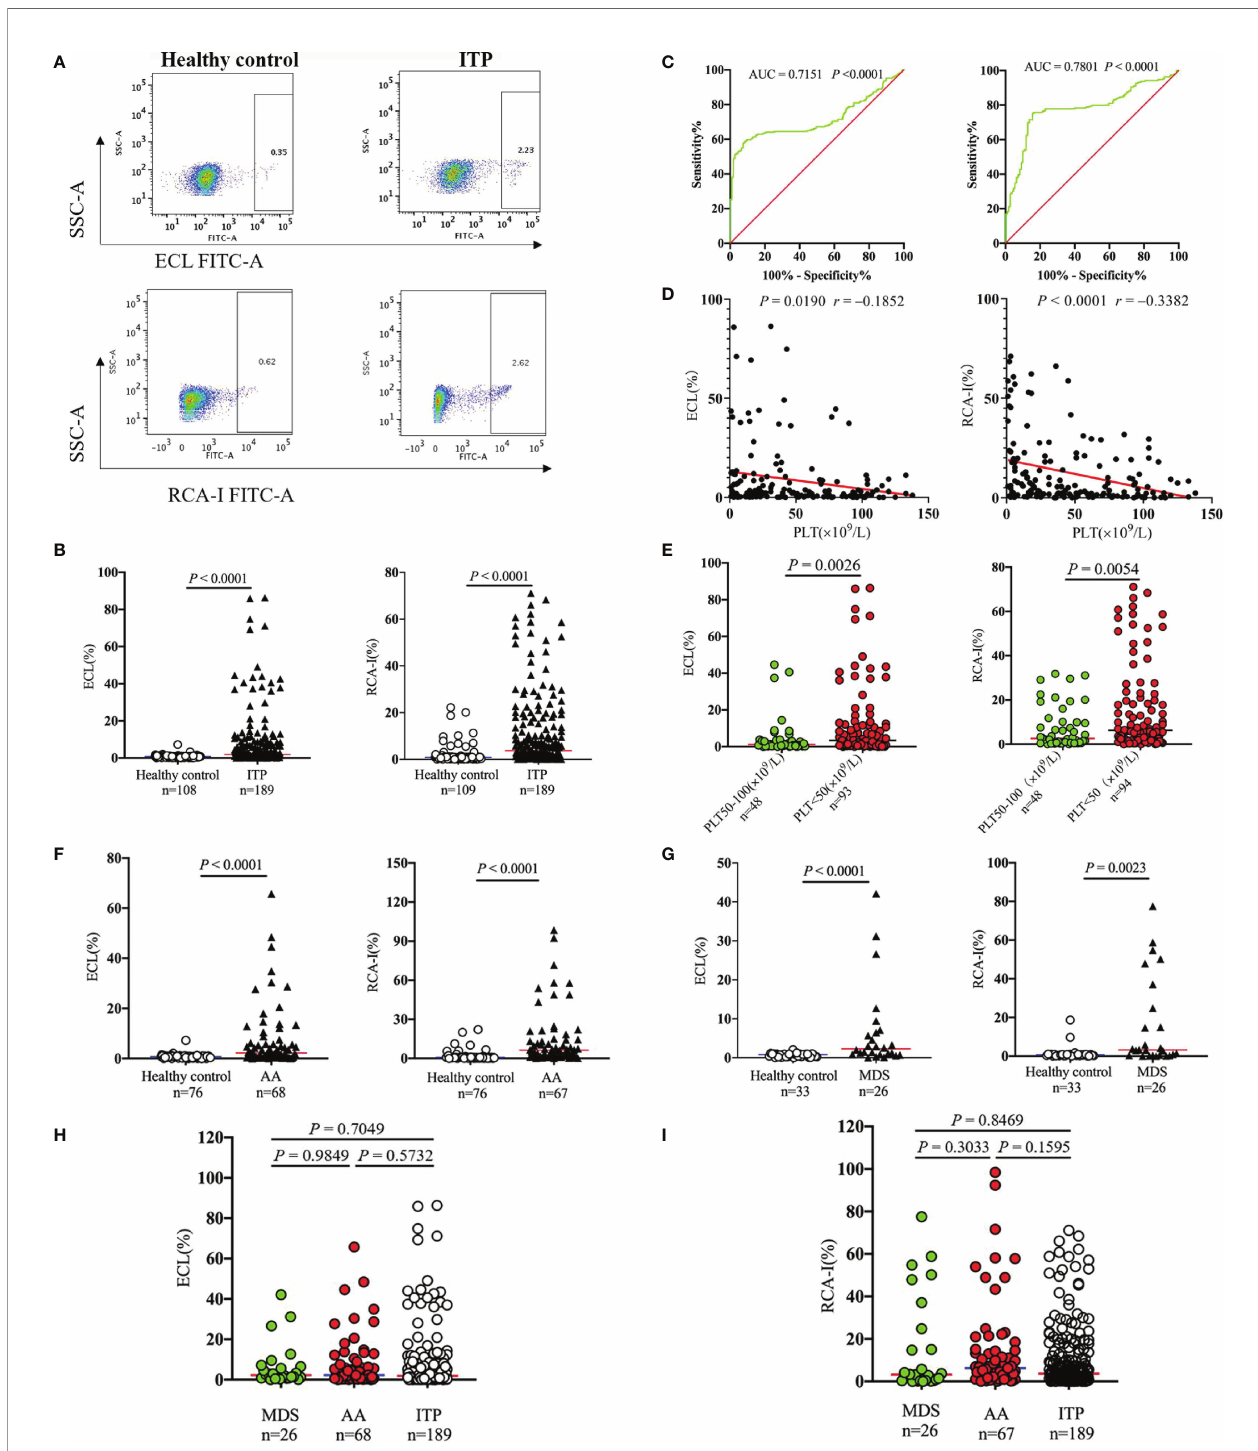
FIGURE 1 | Platelet desialylation in patients with immune thrombocytopenia (ITP) and non-ITP related thrombocytopenia. (A) ECLor RCA-Ibinding to platelets were examinedby fl ow cytometry; representative dot plots from healthycontrol and ITP patients are shown. (B) Comparisonofplatelet desialylation levelsbetween ITP patients andhealthycontrols. (C) ROC curvefor predicting platelet desialylation inITP patients basedonECL(left) and RCA-I (right) binding methods. (D) Correlation analysis between platelet desialylation and platelet count (<150×10 9 /L) as determinedby Spearman ’ s test. (E) Comparison of desialylated platelet levelsinITP patients with different platelet count. (F, G) Platelet desialylation levels inpatients with aplastic anemia (AA), or myelodysplasticsyndrome (MDS)versus healthycontrols. (H,I) Comparison of desialylated platelet levels amongAA, MDS, and ITP groups. ECL, Erythrina cristagalli lectin; RCA-I, Ricinuscommunis agglutinin I; ROC, Receiver operating